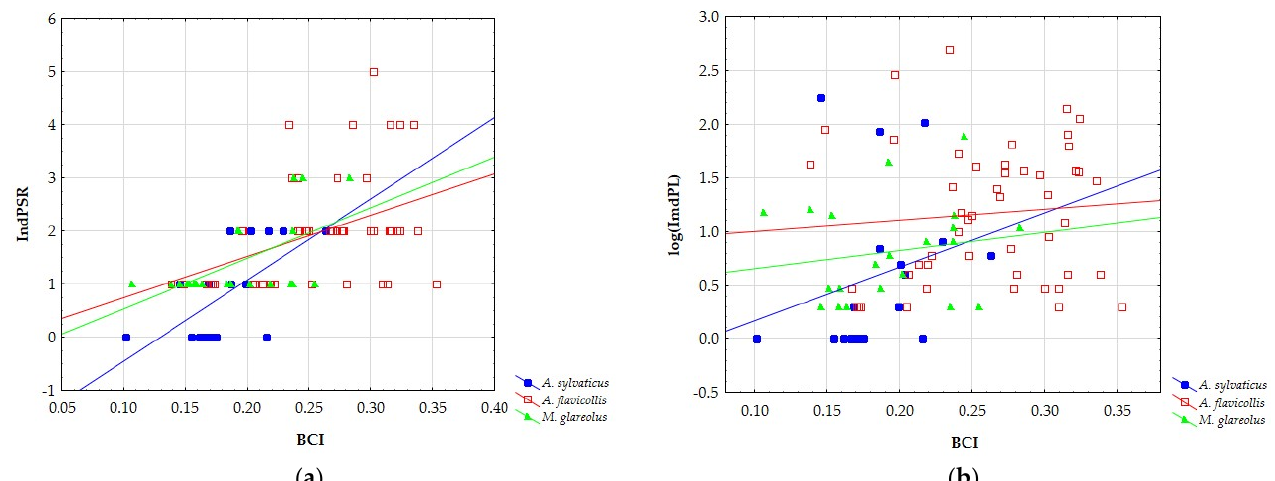
Figure 1. The relationship between the body condition index (BCI) to ( a ) individual parasite species richness IndPSR and ( b ) parasite load (IndPL).